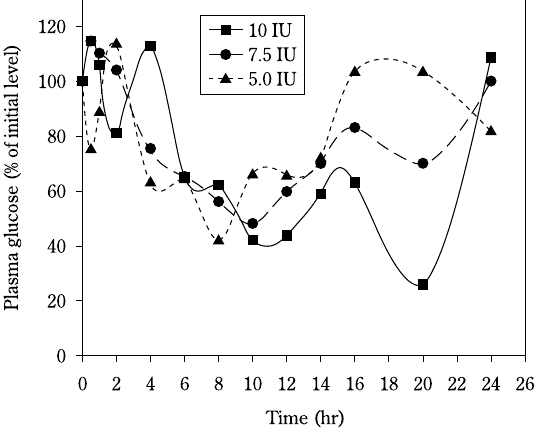
Fig. 9 Nanoparticles effect on blood glucose level change of mouse at dietary state in vivo .